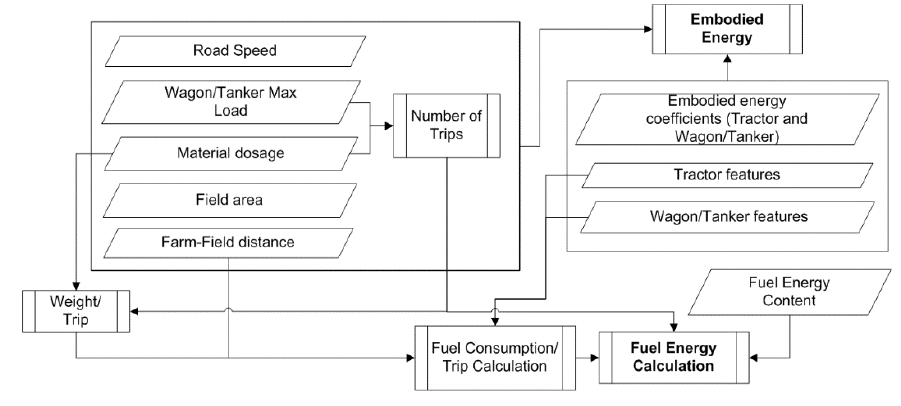
Figure 4. Farm-field material transport operations.